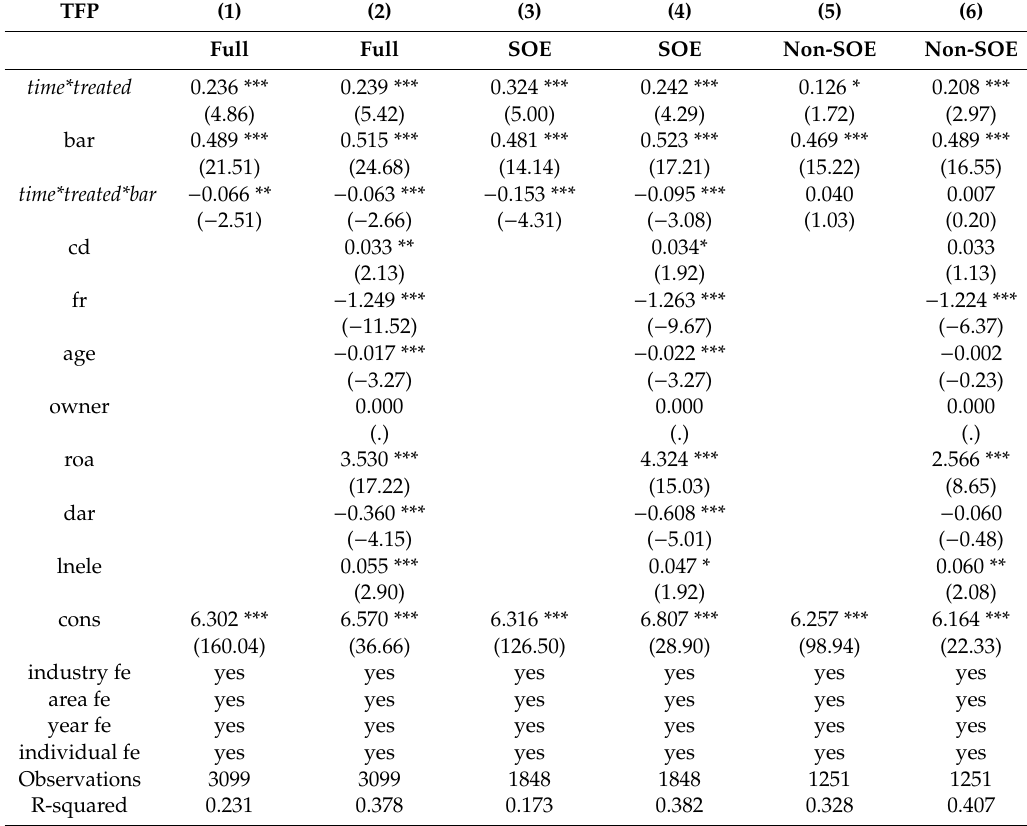
Table 8. Results of moderating e ff ect of bargaining